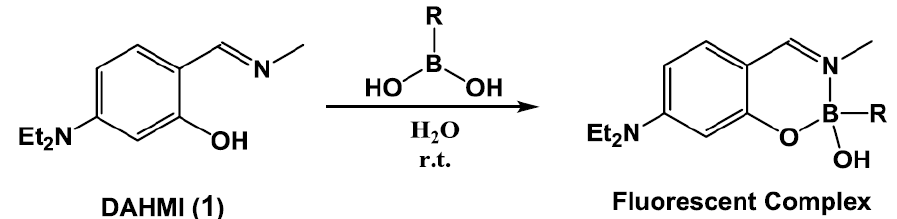
Figure 2. Complex formation using the previously reported fluorescent boron sensor DAHMI ( 1 ).